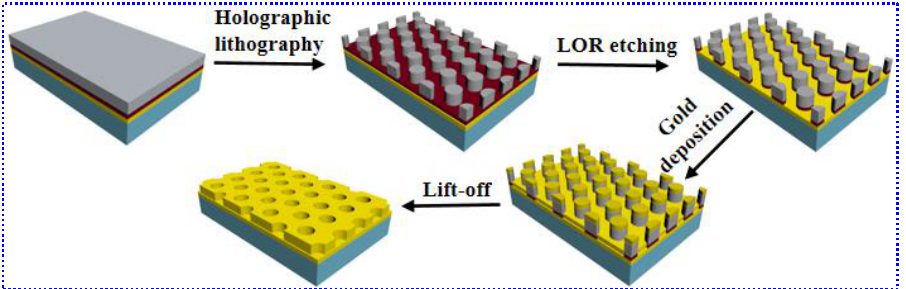
Figure 1. Schematic illustration of the preparation processes of the gold nanohole arrays (Au NHAs).